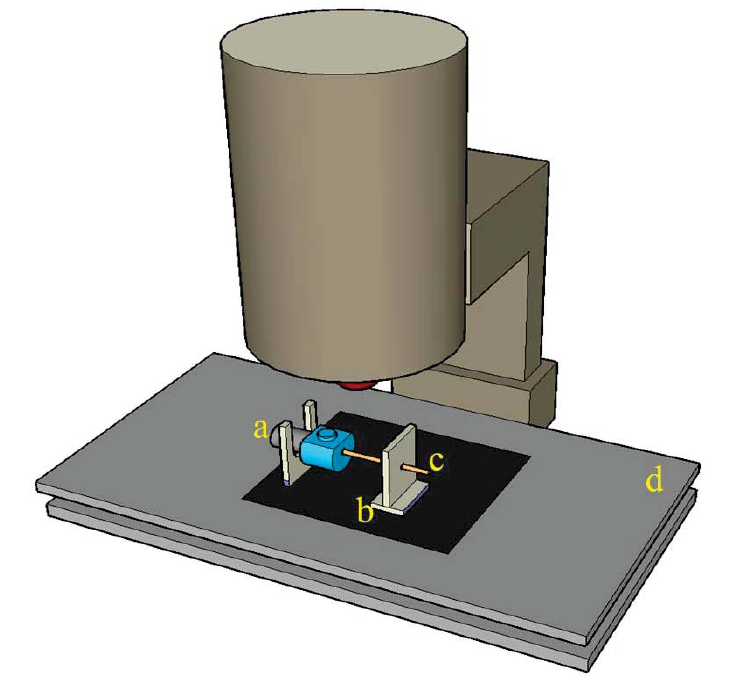
Figure 8. Schematic of the measuring instrument: ( a ) fiber connecter; ( b ) measuring fixture; ( c ) processed fiber; and ( d ) micro-stage.